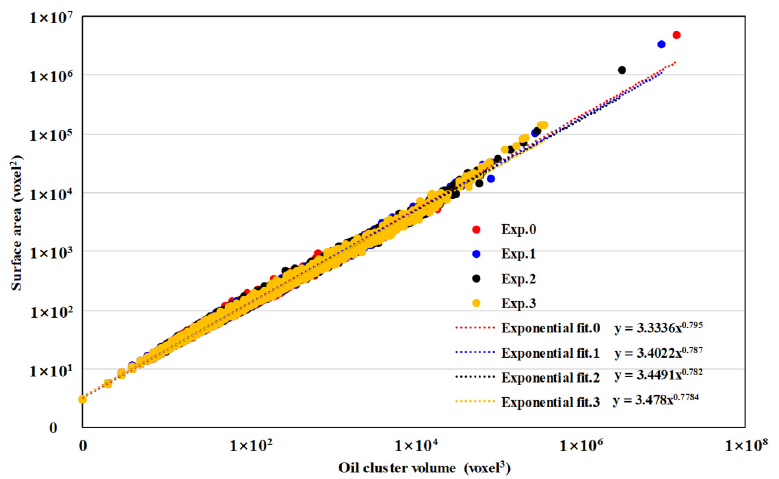
Figure 12. Surface area of each oil cluster plotted against its cluster volume in different stages.